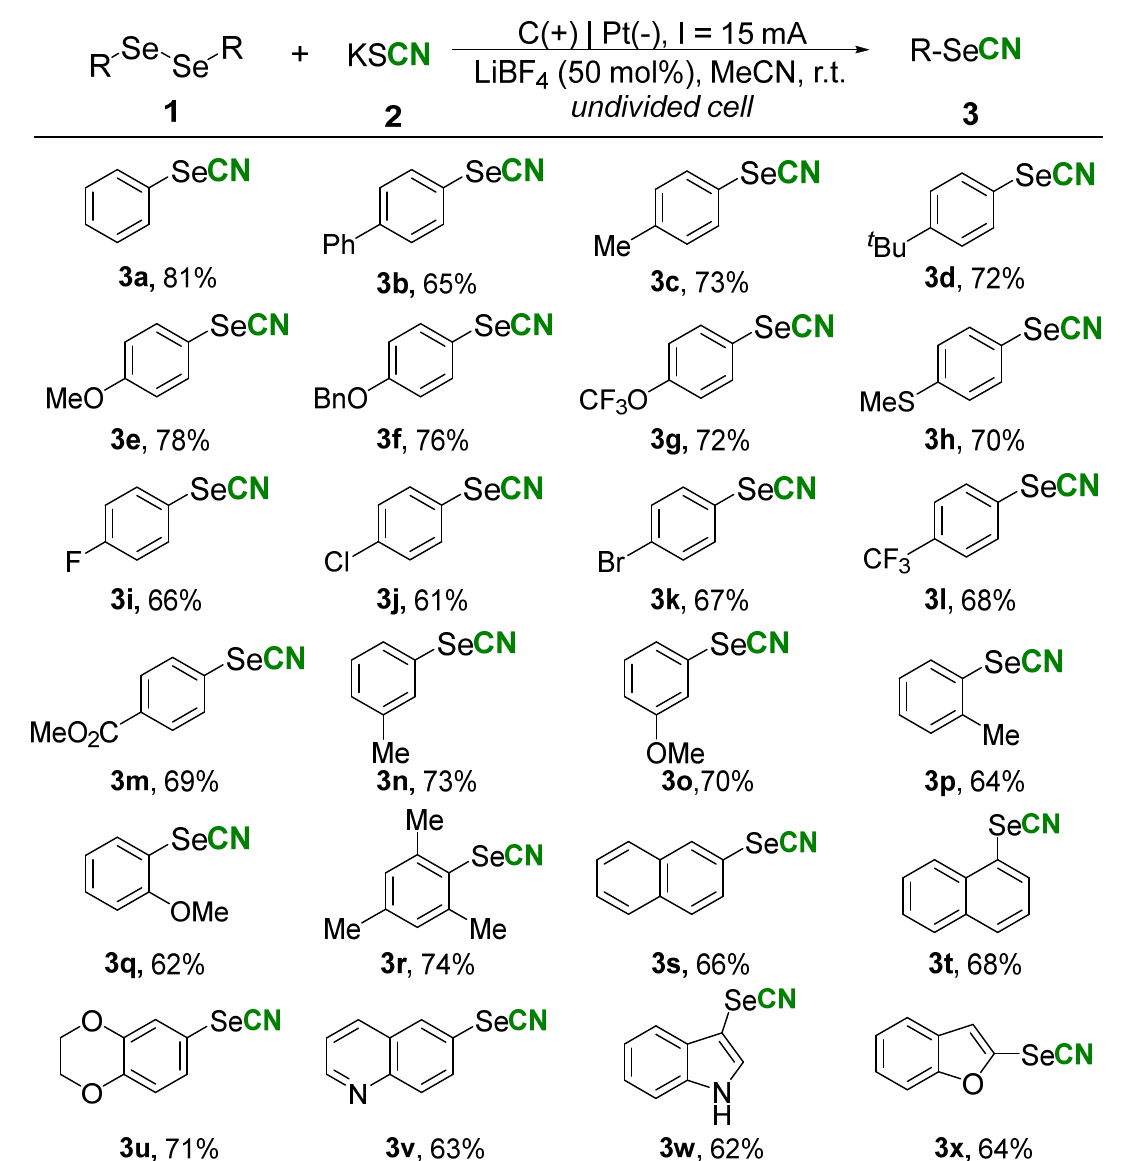
Scheme 2. Conditions: C (15 mm × 10 mm × 2 mm) as the anode, Pt (15 mm × 10 mm × 0.1 mm) as the cathode, 1 (0.2 mmol), 2 (0.5 mmol), LiBF 4 (0.1 mmol), MeCN (6 mL), ambient temperature,